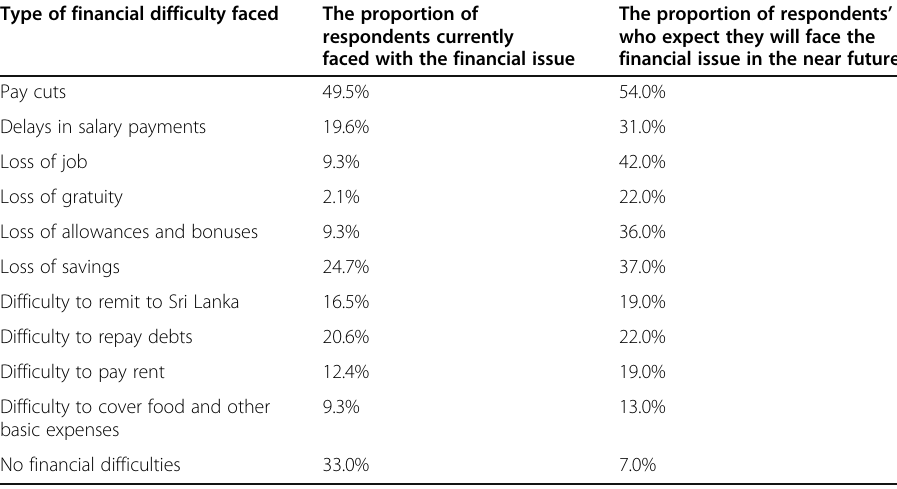
Table 2 Comparison of present and anticipated financial issues faced by Sri Lankan migrants in